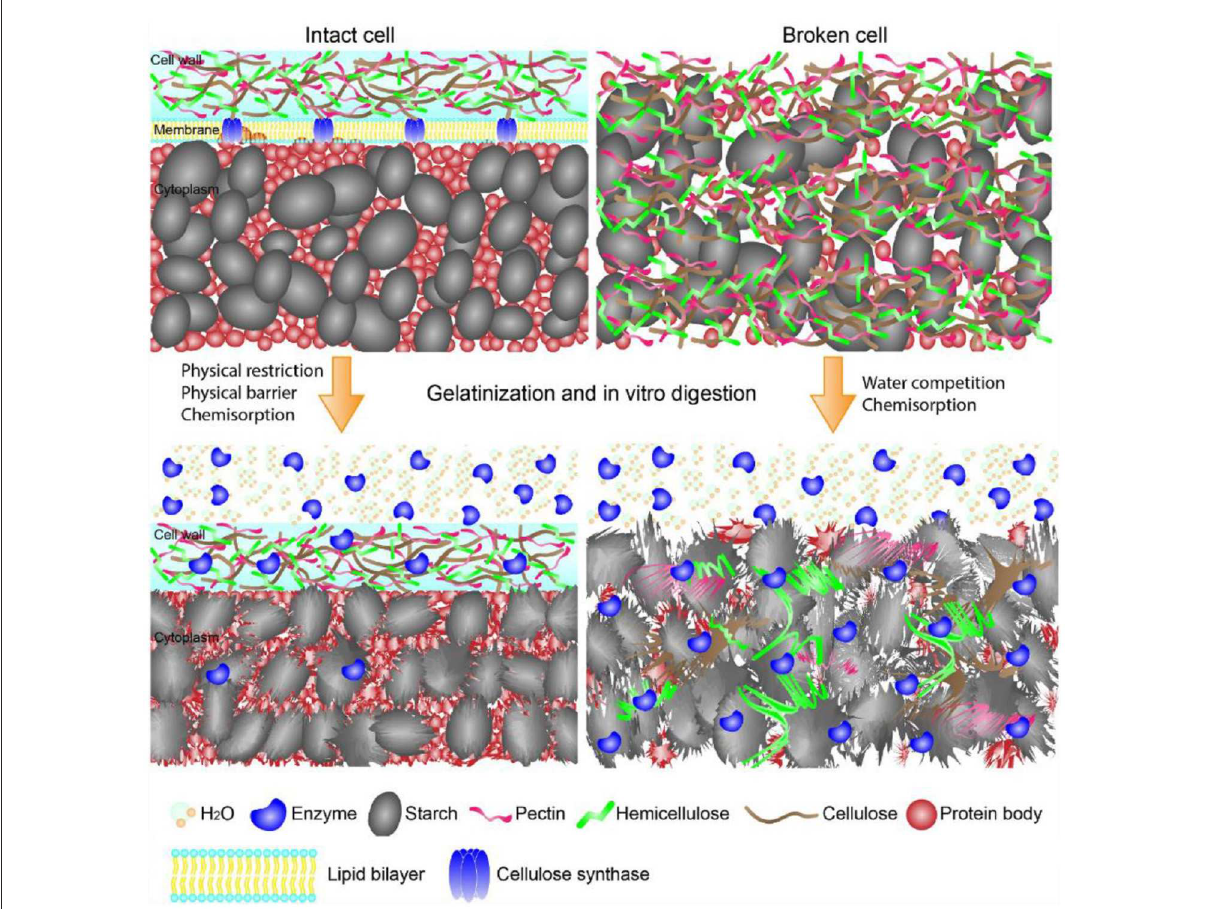
FIGURE1 Schematic showing the structures of starch-containing intact and broken cells during gelatinization and in vitro digestion. The intact cell walls limited enzymes and water diffusion onto starch, while the intact cell walls yielded starch complete gelatinization and enzymes diffusion onto starch surface. The graph is collected from Li et al.